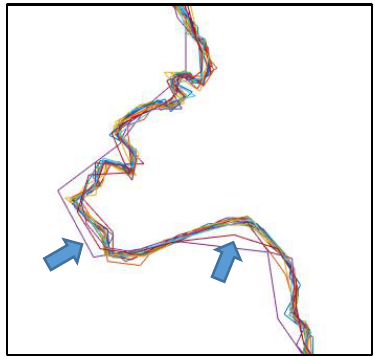
Fig 7 Polygons collected with low quality